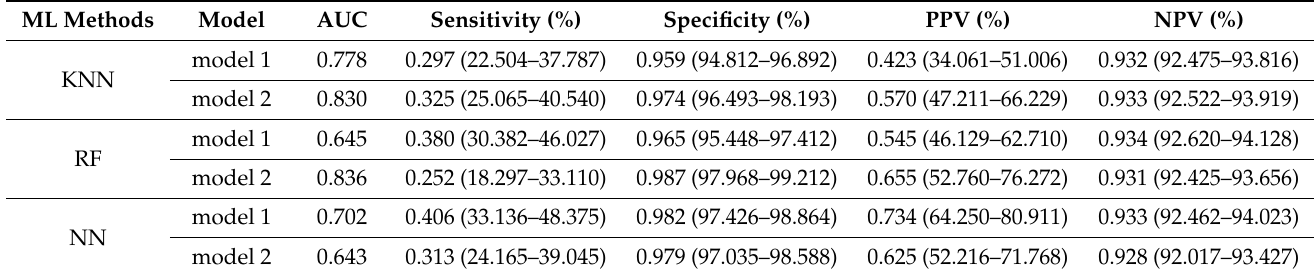
Table 3. Diagnostic characteristics of suicidal ideation assessments in each machine learning model.